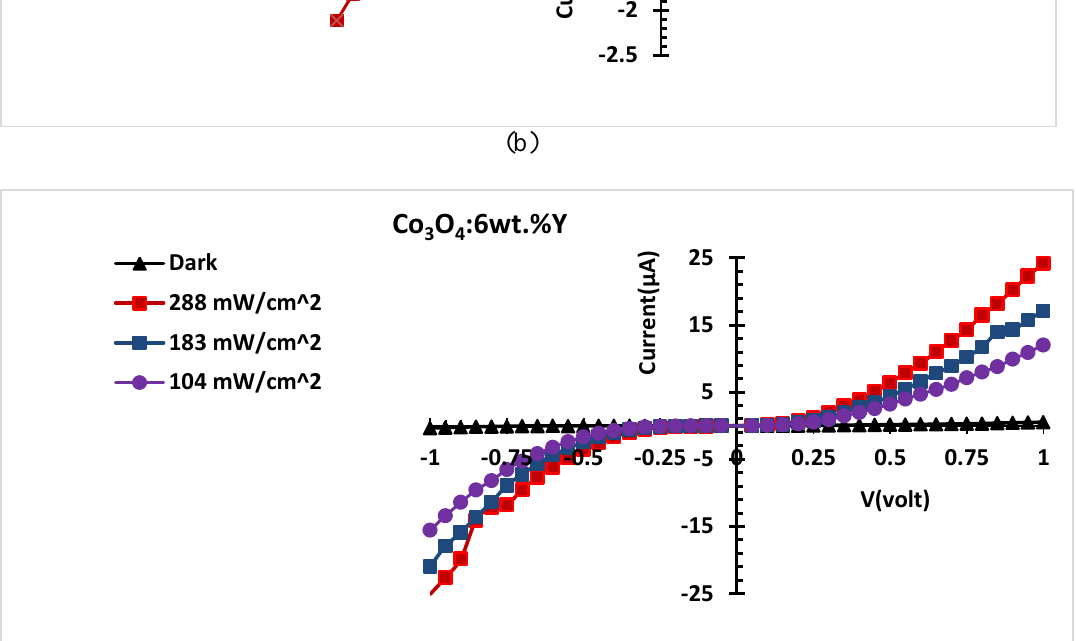
Fig. 4: I-V characteristics in the dark and under illumination for pure and doped Co with